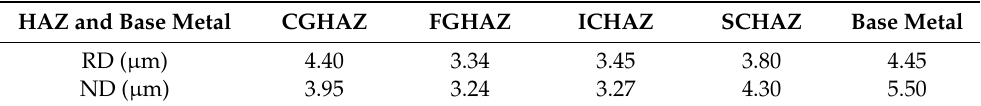
Table 2. Effective grain size of different HAZs measured by line intercept method of EBSD. HAZ and Base